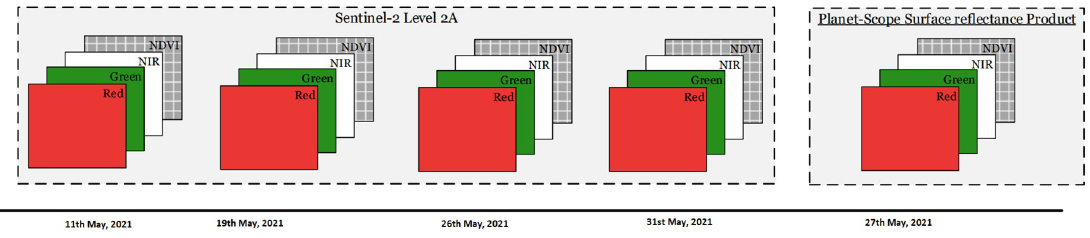
Fig 4. Timeline of the acquired images of the regions of